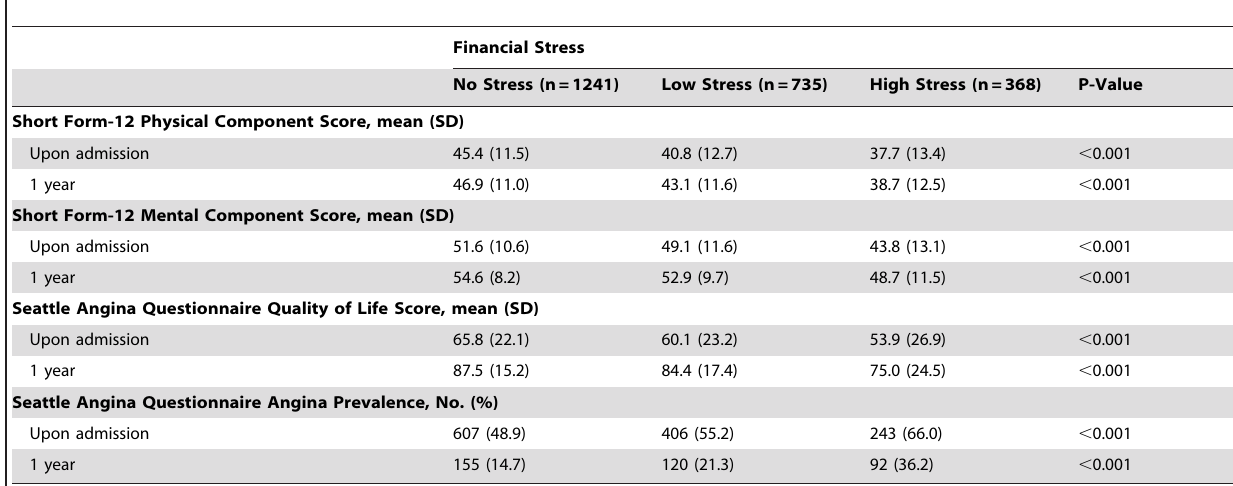
Table 2. Health Status at Baseline and at 1 Year of Patients Admitted for Acute Myocardial Infarction, Stratified by Patient Reporting of Financial